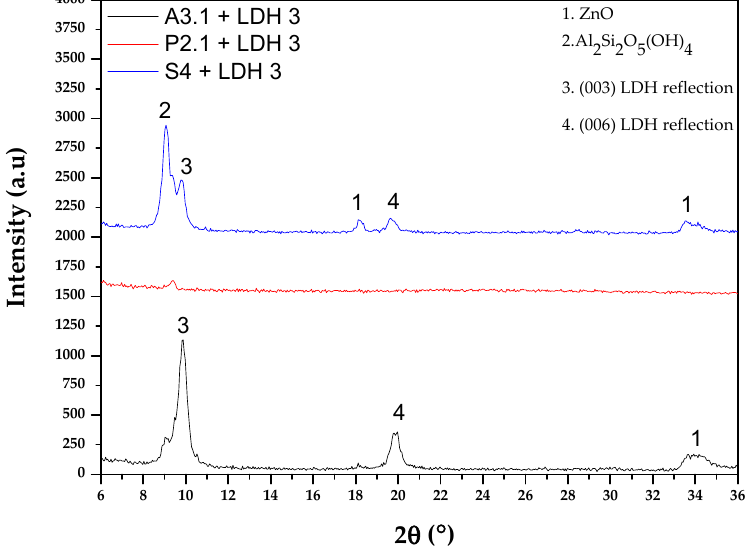
Figure 7. XRD patterns of Zn-Al-LDH-coated A3.1, P2.1 and S4 PEO coatings.